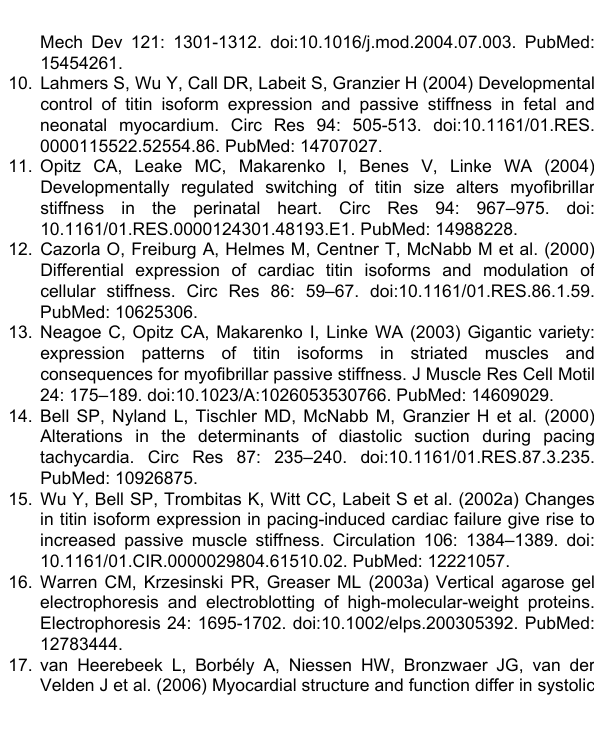
Table S3. Left ventricle microarray comparisons of transcripts from wild type and homozygous Rbm20 knock out rats at 49 days of age.